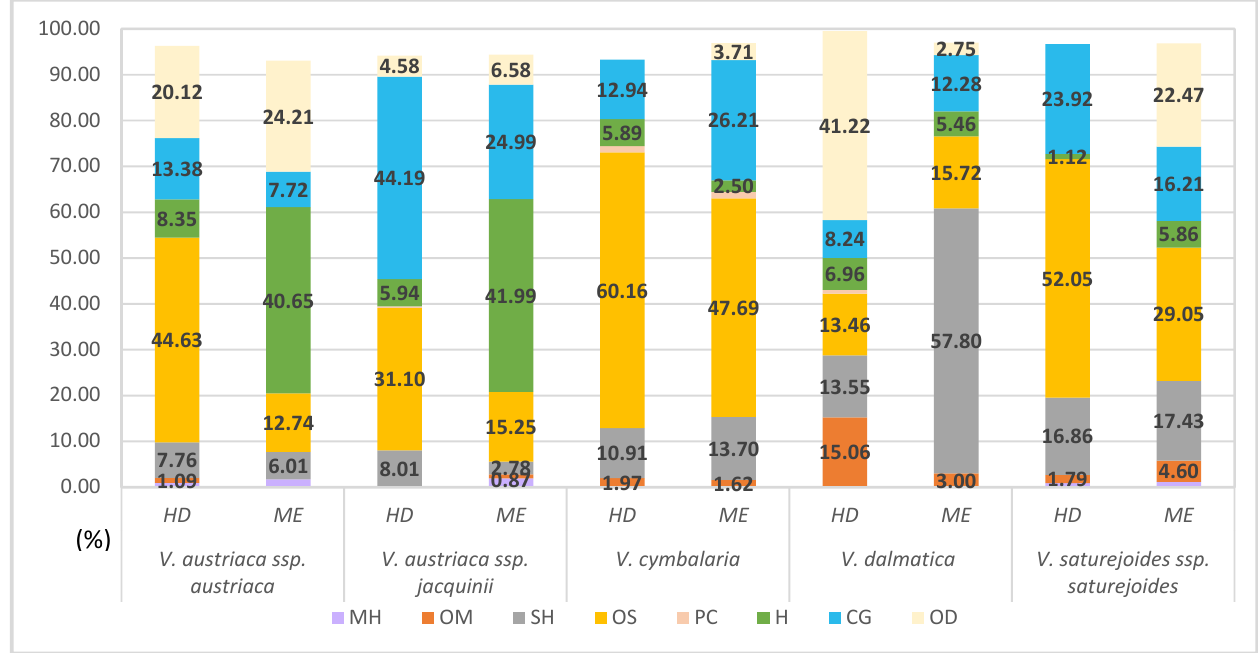
Figure 2. Relative content of volatile compounds in Veronica taxa collected from dry habitats. HD, hydrodistillation; ME, microwave extraction; MH, monoterpene hydrocarbons; OM, oxygenated monoterpenes; SH, sesquiterpene hydrocarbons; OS, oxygenated sesquiterpenes; PC, phenolic compounds; H, hydrocarbons; CG, common group of acids, alcohols, and esters; OD, oxygenated